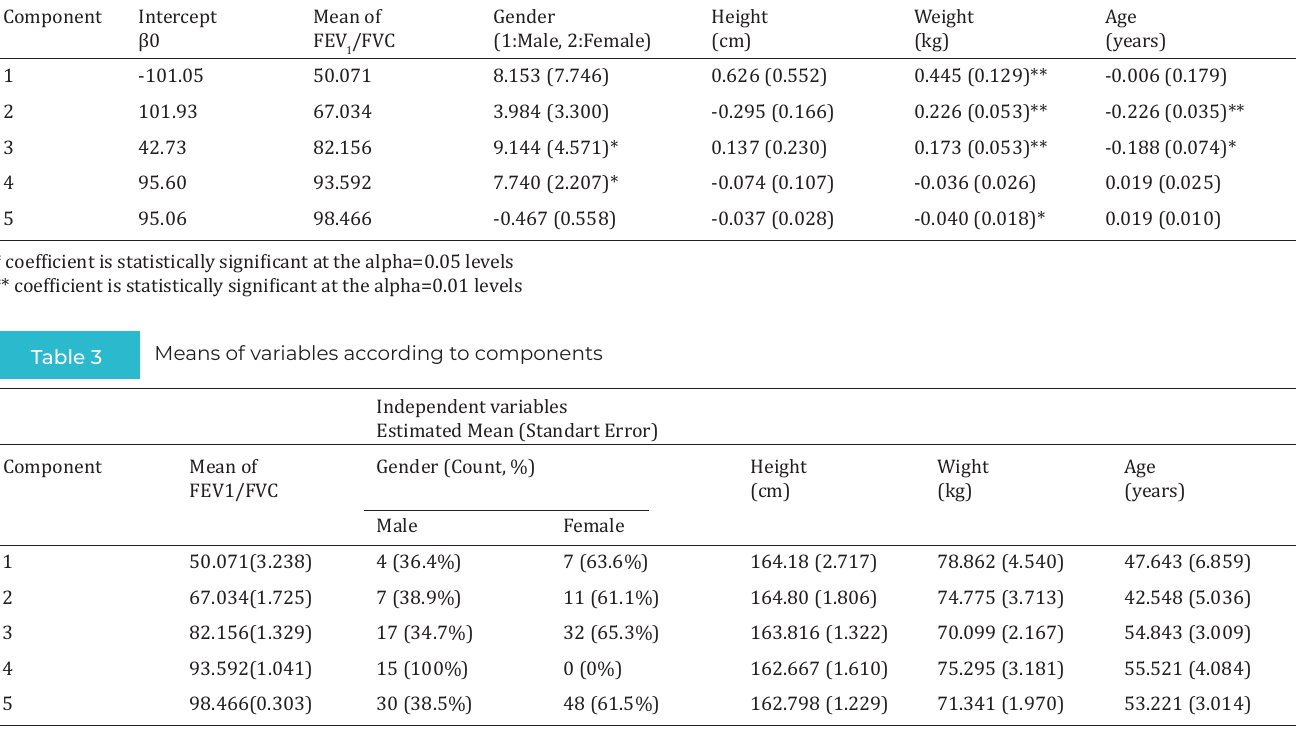
Independent variables Estimated Coefficient (Standart